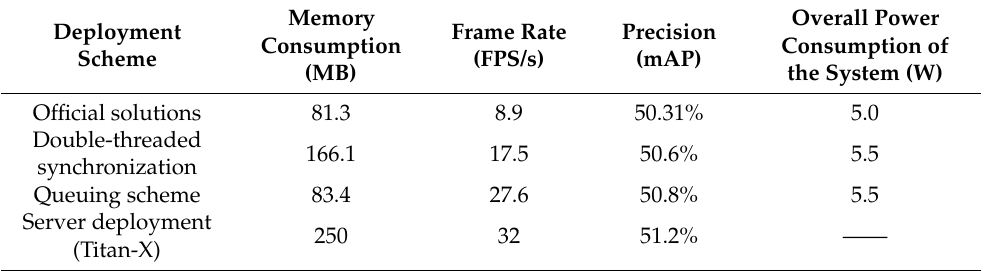
Table 4. The comparison between different deployment schemes.